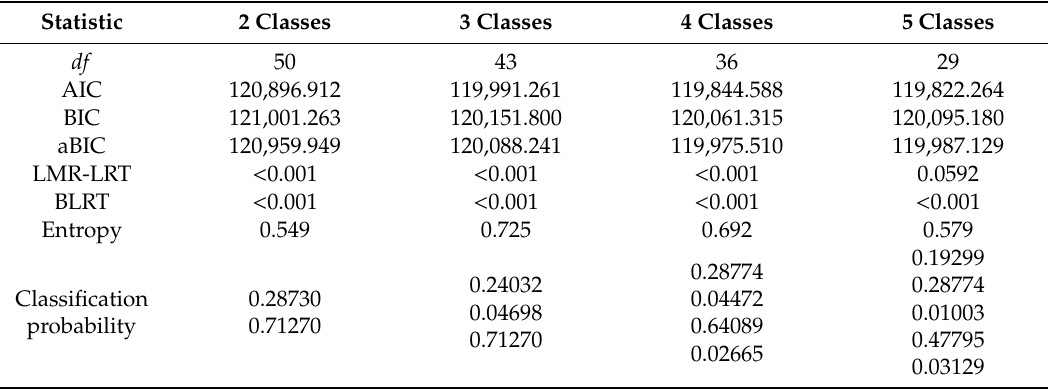
Table 2. Model fit statistics for each of the fitted latent class analysis